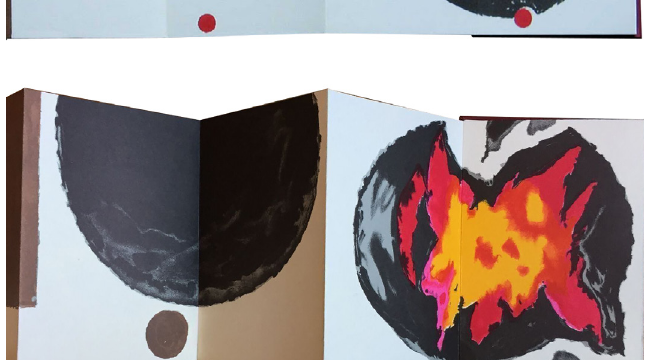
Fig. 5 Warja Lavater. Little Red Riding Hood is in front of the wolf lying on the bed ; The wolf devours Little Red Riding Hood . Warja Lavater (1963). Le Petit Chaperon Rouge . Paris: Maeght.